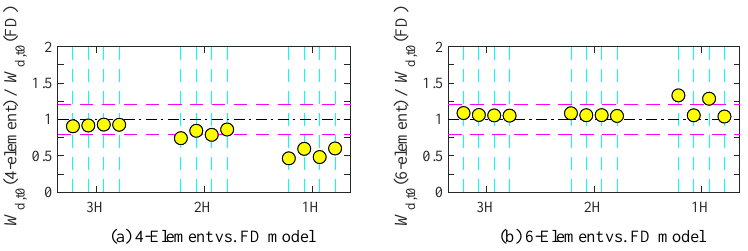
Figure 28. Ratio of the total accumulated energy dissipation of the VE dampers (across-wind): (HH, SH, HS, SS from left to right of each